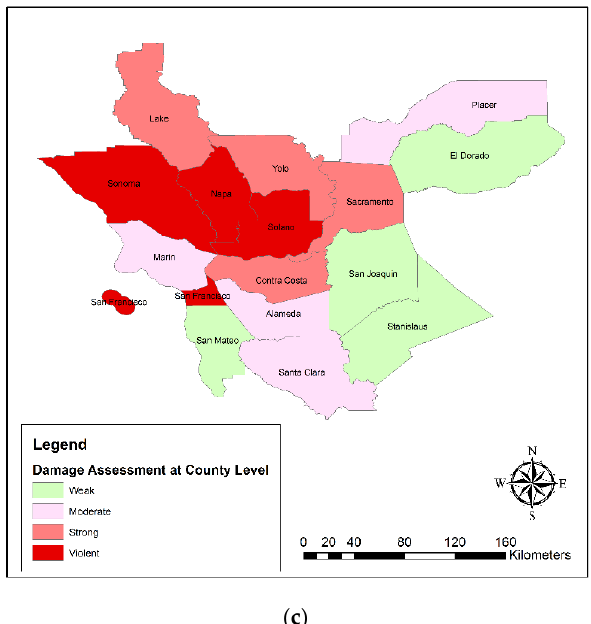
Figure 10. The estimated damage map from ( a ) Naive Bayes, ( b ) SVM, and ( c ) deep learning algorithms at the county scale.